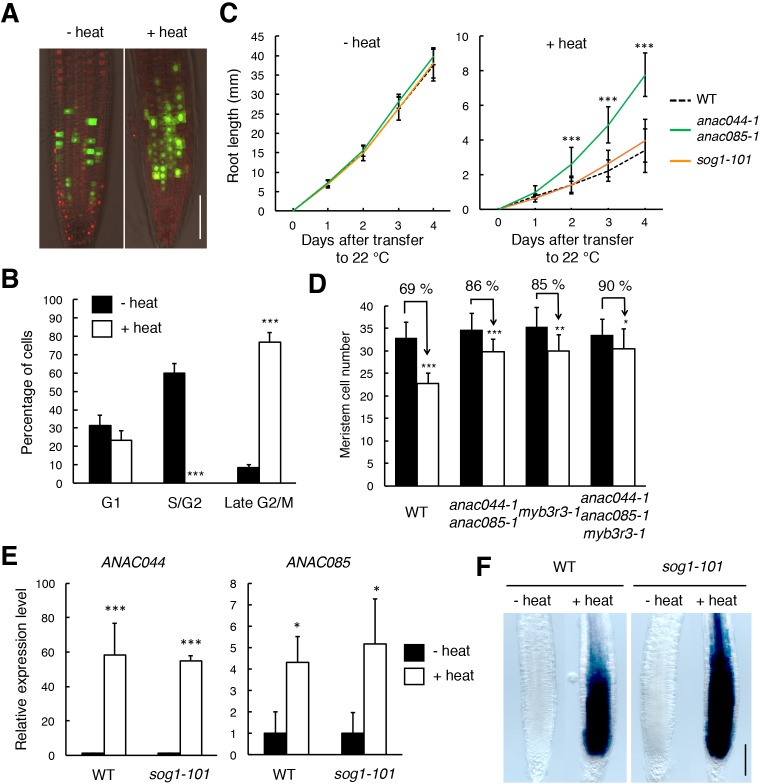
ANAC044 and ANAC085 are involved in the heat stress response in roots.(A, B) Heat stress-induced cell cycle arrest in the root tip. Five-day-old seedlings carrying the cell cycle marker system Cytrap were incubated at 22°C (- heat) or 37°C (+heat) for 24 hr. Signals of ProHTR2:CDT1a (C3)-RFP (S/G2 marker; red) and ProCYCB1;1:CYCB1;1-GFP (late G2/M marker; green) were observed (A). Bar = 100 µm. Cells with RFP or GFP signals were estimated to be in S/G2 or late G2/M, respectively, and those with no fluorescence were counted as G1-phase cells (B). Data are presented as mean ± SD (n = 10). Significant differences from the control (22°C) were determined by Student’s t-test: ***, p<0.001. (C) Root growth of WT, anac044-1 anac085-1 and sog1-101 under heat stress. Five-day-old seedlings were incubated at 22°C (- heat) or 37°C (+heat) for 24 hr, and transferred to 22°C to measure root length every 24 hr. Data are presented as mean ± SD (n > 13). Significant differences from WT were determined by Student’s t-test: ***, p<0.001. (D) Cortical cell number in the root meristem after heat stress. Five-day-old seedlings of WT, anac044-1 anac085-1, myb3r3-1 and anac044-1 anac085-1 myb3r3-1 were incubated at 22°C (black bars) or 37°C (white bars) for 6 hr. Data are presented as mean ± SD (n > 15). Significant differences from the control (22°C) were determined by Student’s t-test: *, p<0.05; **, p<0.01; ***, p<0.001. (E) Transcript levels of ANAC044 and ANAC085 under heat stress. Five-day-old seedlings of WT and sog1-101 were incubated at 22°C (- heat) or 37°C (+heat) for 24 hr, and total RNA was extracted. mRNA levels were normalized to that of ACTIN2, and are indicated as relative values, with that for the control (22°C) set to 1. Data are presented as mean ± SD (n = 3). Significant differences from the control (22°C) were determined by Student’s t-test: *, p<0.05, ***, p<0.001. (F) GUS staining of WT and sog1-101 roots harbouring ProANAC044:GUS. Five-day-old seedlings were incubated at 22°C (- heat) or 37°C (+heat) for 24 hr, followed by GUS staining. Bar = 100 µm.10.7554/eLife.43944.034Figure 8—source data 1.Source data.